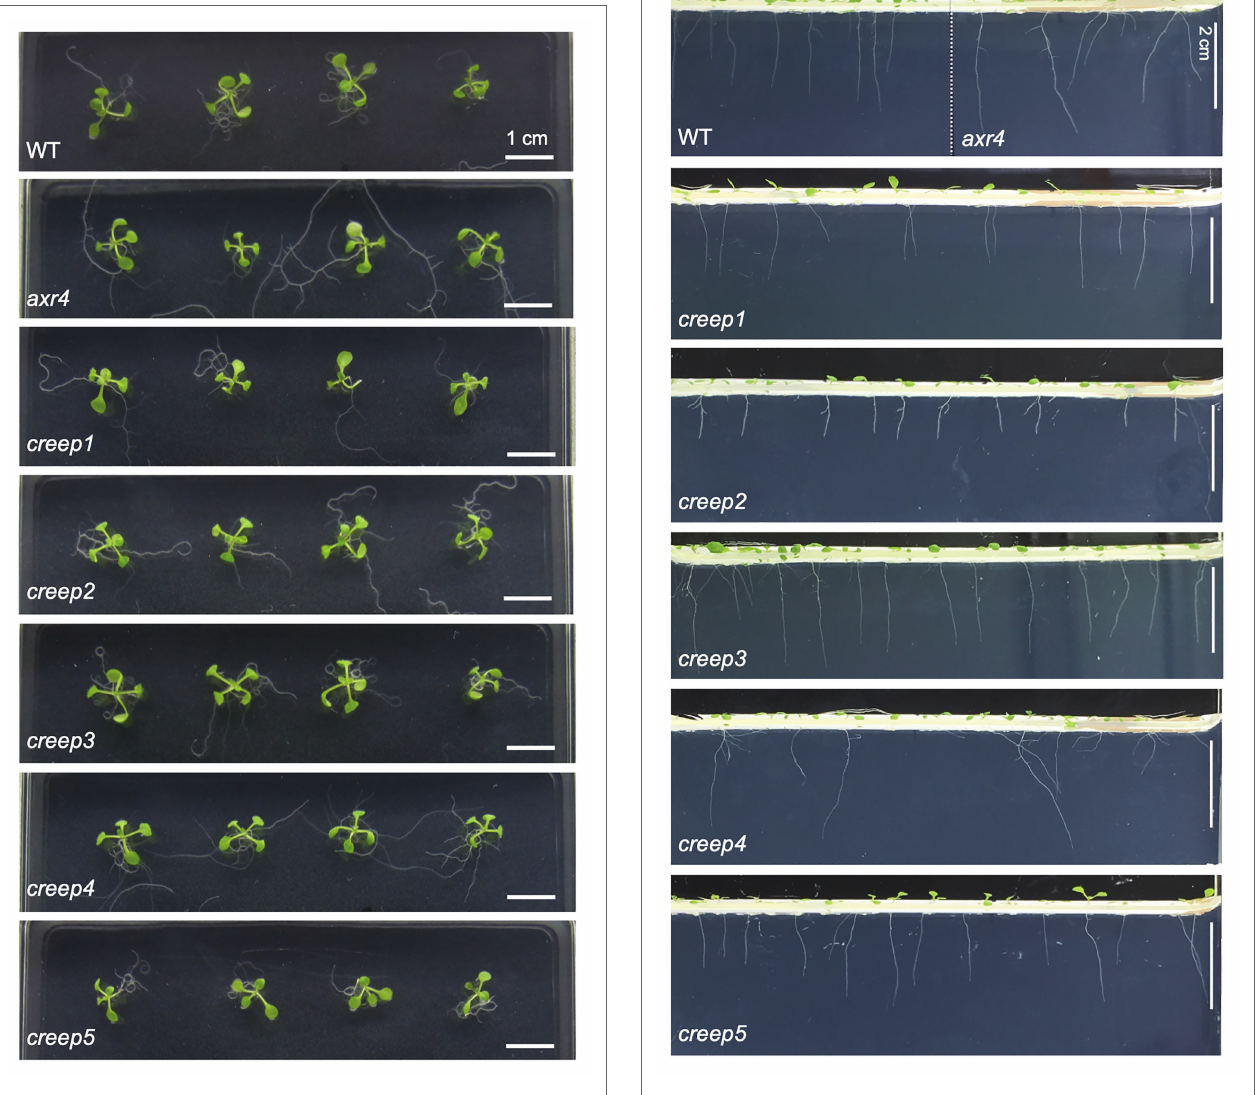
FIGURE 4 | The top view of creep mutants on ordinary, root-penetrable 1/2 MS-0.4% gellan gum medium. The seeds of each line were sown and incubated at 22 ° C. Photographs were taken at 8 days after sowing. Scale bar = 1 cm.